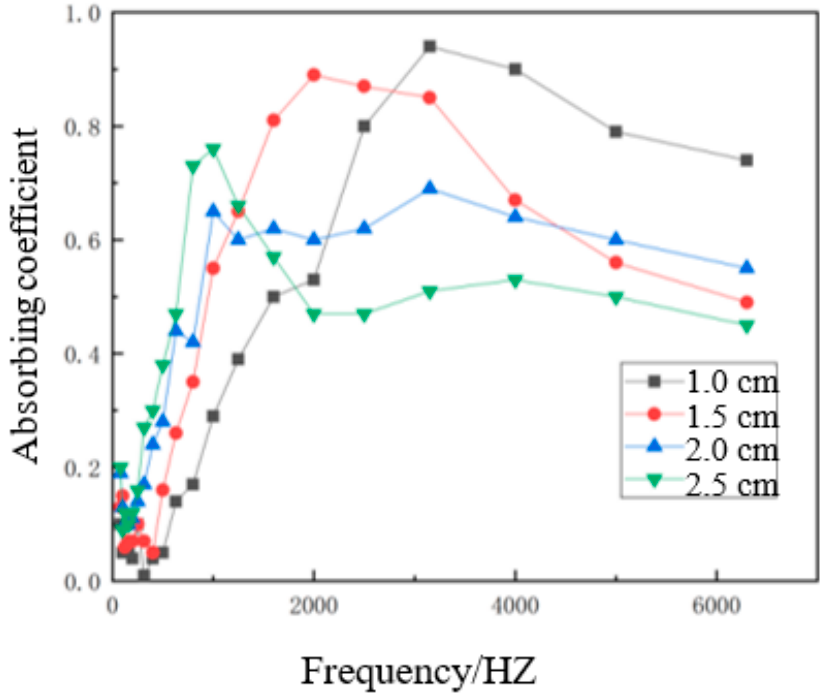
Figure 12. Sound absorption curves of composite materials of different